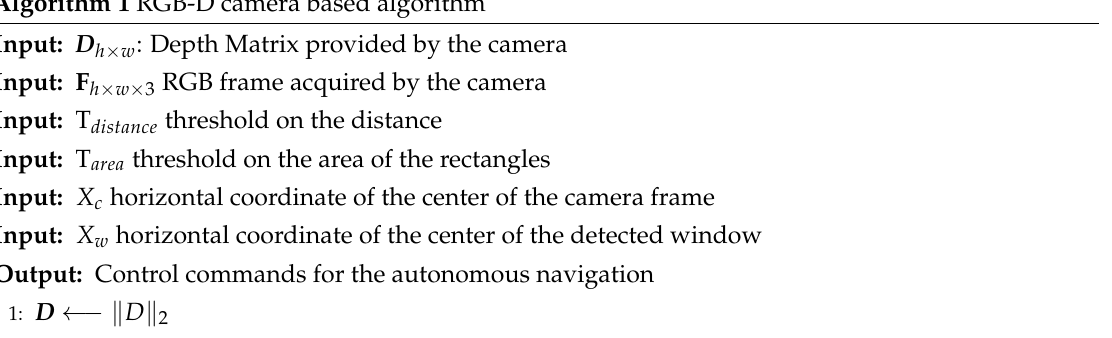
Algorithm 1 RGB-D camera based